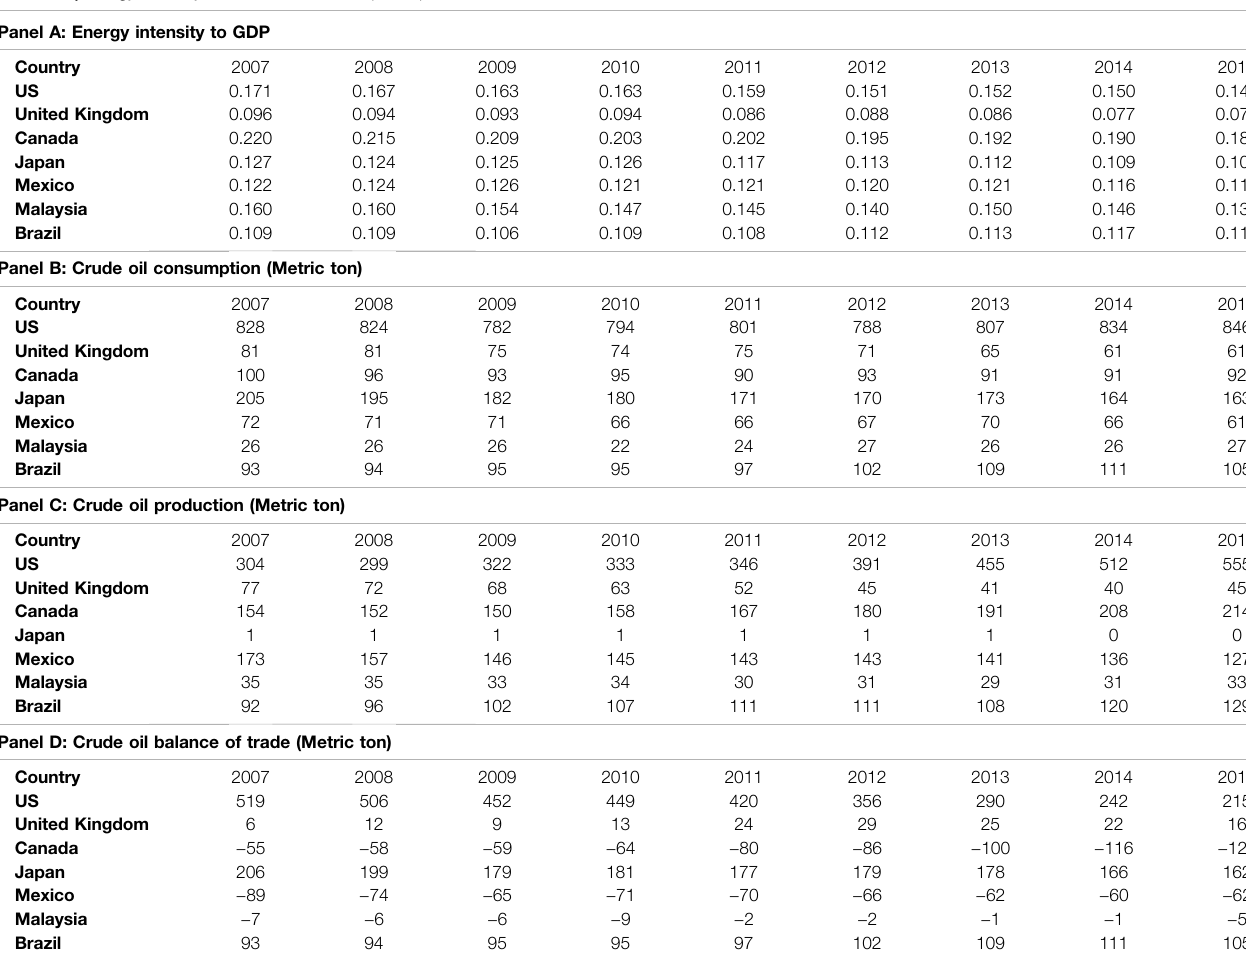
TABLE 1 | Energy intensity and crude oil consumption, production, and trade balance at selected countries. Panel A: Energy intensity to GDP Country